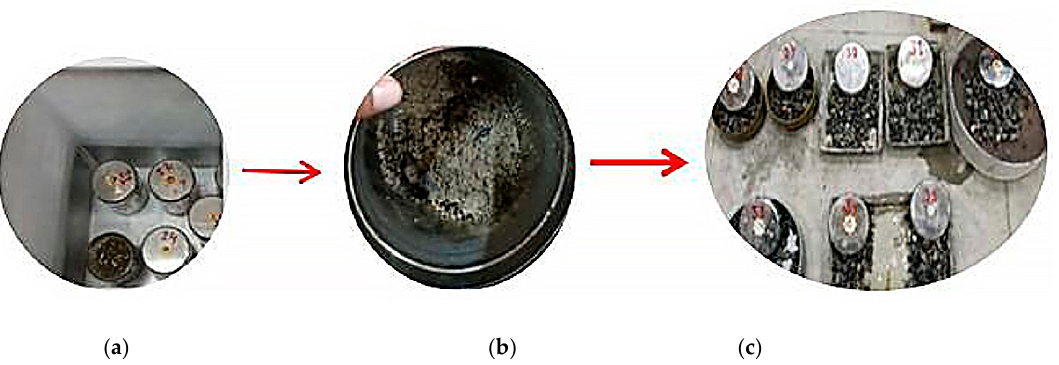
Figure 2. Recycled aggregate is treated using freezing-thawing cycles. ( a ) The sample of frozen RA; ( b ) Remove aggregate mortar; ( c ) Treated recycled aggregate.